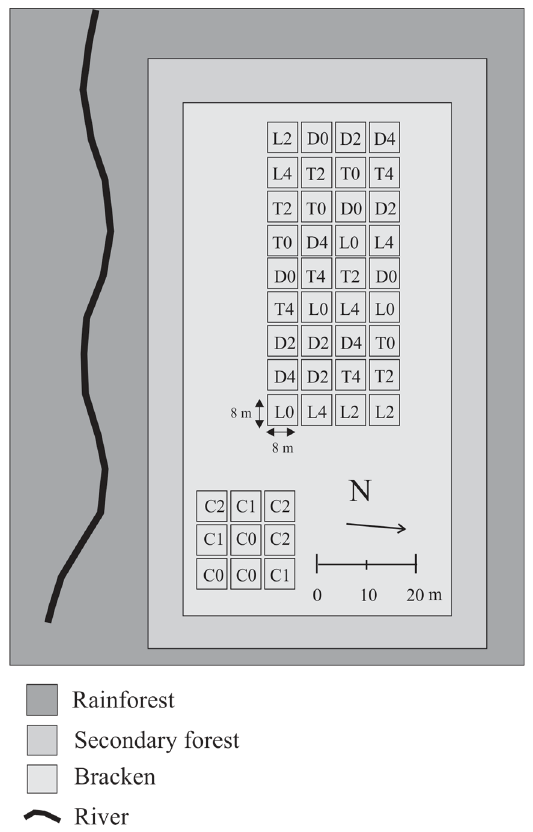
Figure 1. Spatial arrangement of treatments in the experiment, including the type of forest that covered the surroundings of the experimental area. D: Direct sowing; L: Traditional Lacandon method (broadcasting); T: Transplanting; C: